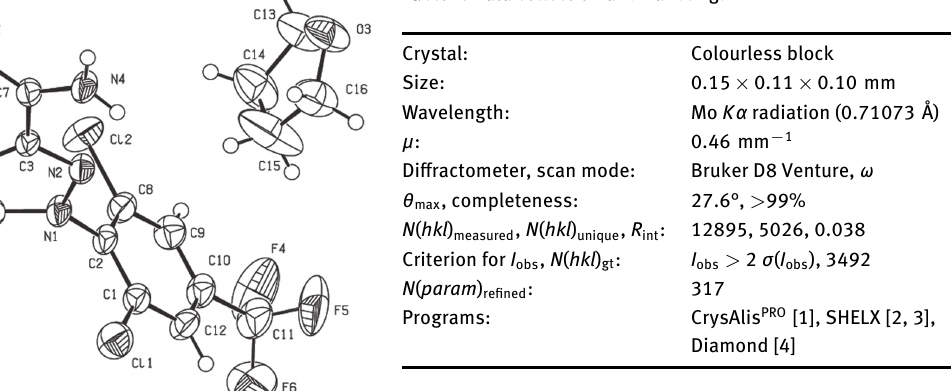
Table 1: Data collection and handling.